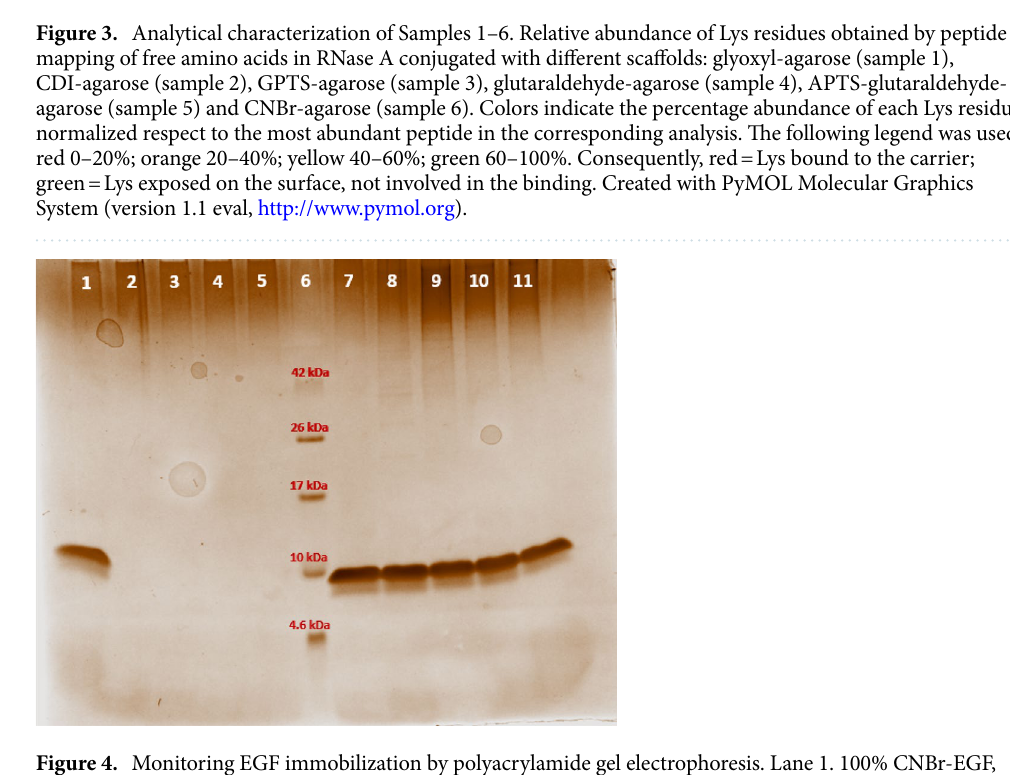
Figure 4. Monitoring EGF immobilization by polyacrylamide gel electrophoresis. Lane 1. 100% CNBr-EGF, 0 h; Lane 2. 0% CNBr-EGF, 1 h; Lane 3. 0% CNBr-EGF, 2 h; Lane 4. 0% CNBr-EGF, 3 h; Lane 5. 0% CNBr-EGF, 4 h; Lane 6. 4.6–42 kDa Ladder; Lane 7. 100% Glyoxyl-EGF, 0 h; Lane 8. 100% Glyoxyl-EGF, 1 h; Lane 9. 86.5% Glyoxyl-EGF, 2 h; Lane 10. 86% Glyoxyl-EGF, 3 h; Lane 11. 87% Glyoxyl-EGF, 4 h. Percentage was referred to the protein found in the supernatant (see “Materials and methods” for details). Quantitative densitometric analysis of the bands was performed with Image Lab software (Fig. S1, Supplementary